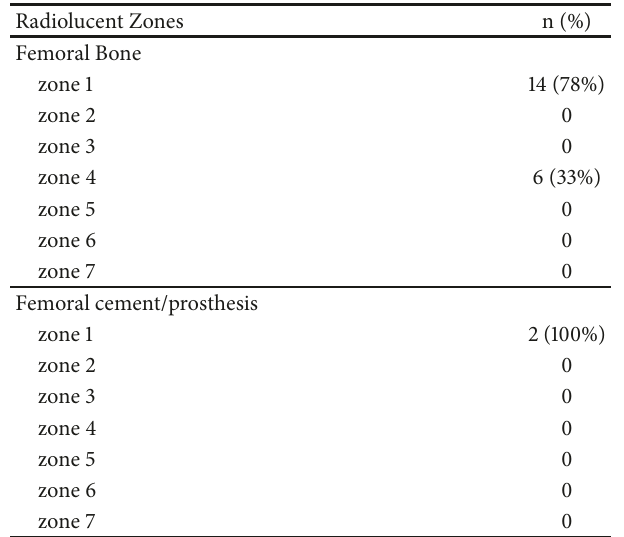
Table 7: Frequency of radiolucent lines in the Lateral Tibial